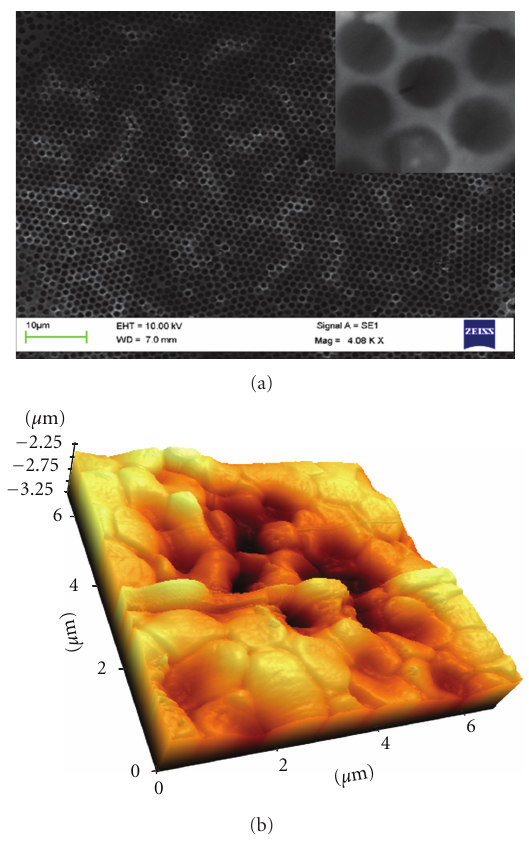
Figure 4: SEM (a) and AFM (b) image of E. coli cells in microwells. Inset image shows a closer caption of the bacterial cells.